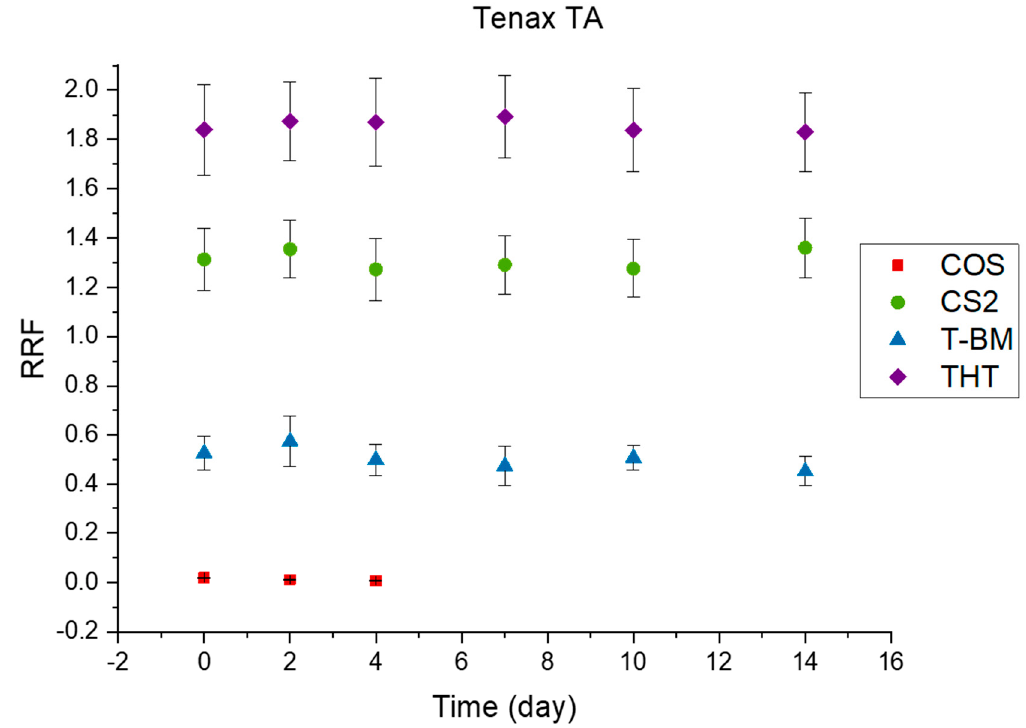
Figure 8. Storage stability of sulphur compounds (~100 nmol/mol) on Tenax TA.